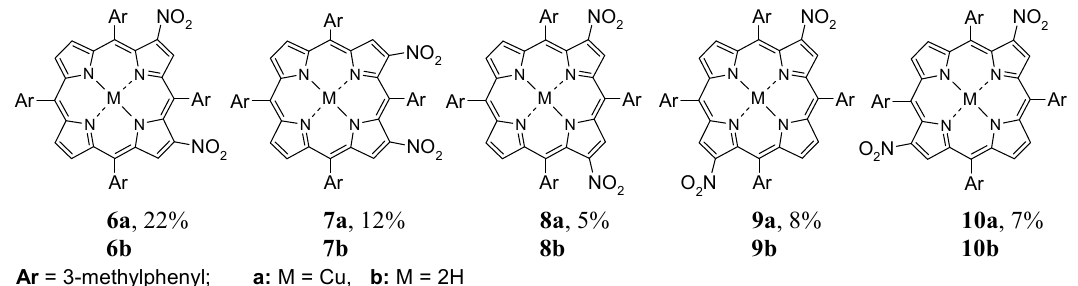
Figure 1. Structures of dinitro-isomers 6a – 10a and 6b–10b .